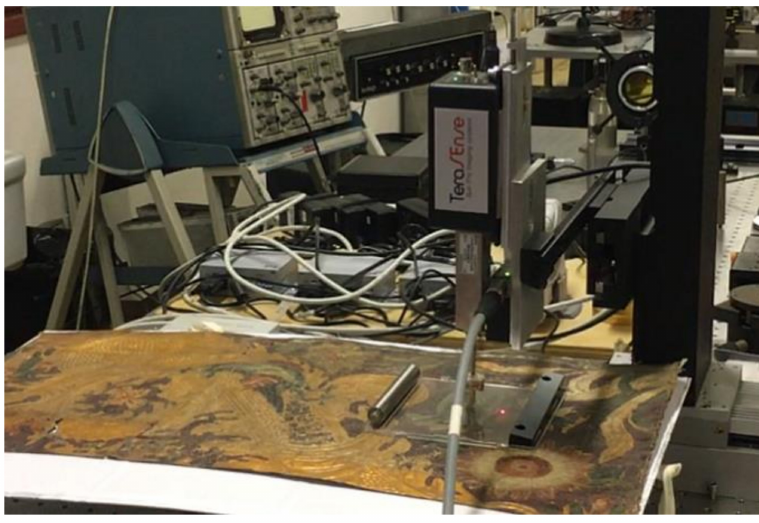
Figure 28. Set-up for THz imaging of leather wallpaper